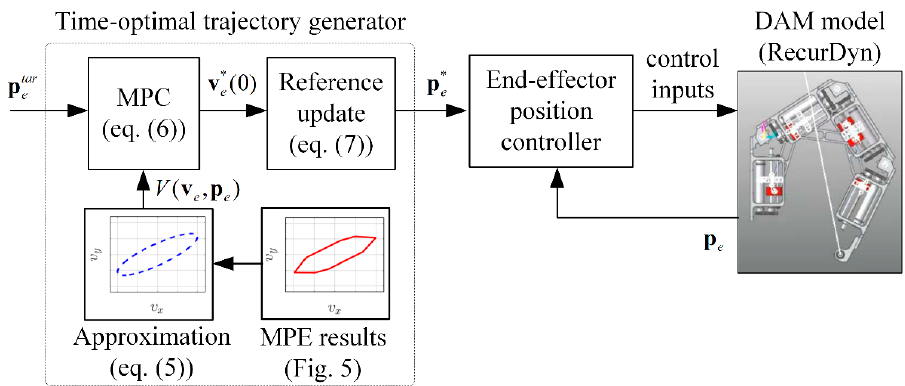
Figure 7. Proposed time-optimal trajectory planning using the MPE results and MPC method.